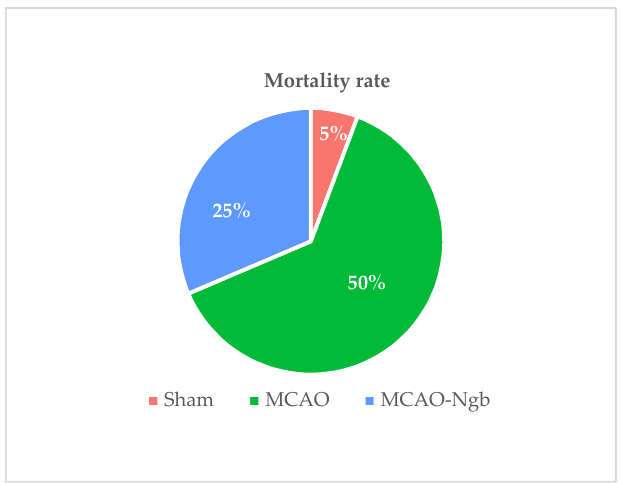
Figure 1. Mortality rates of sham ( n = 23), MCAO ( n = 44), and MCAO-Ngb ( n = 27) groups after 24 h of reperfusion.